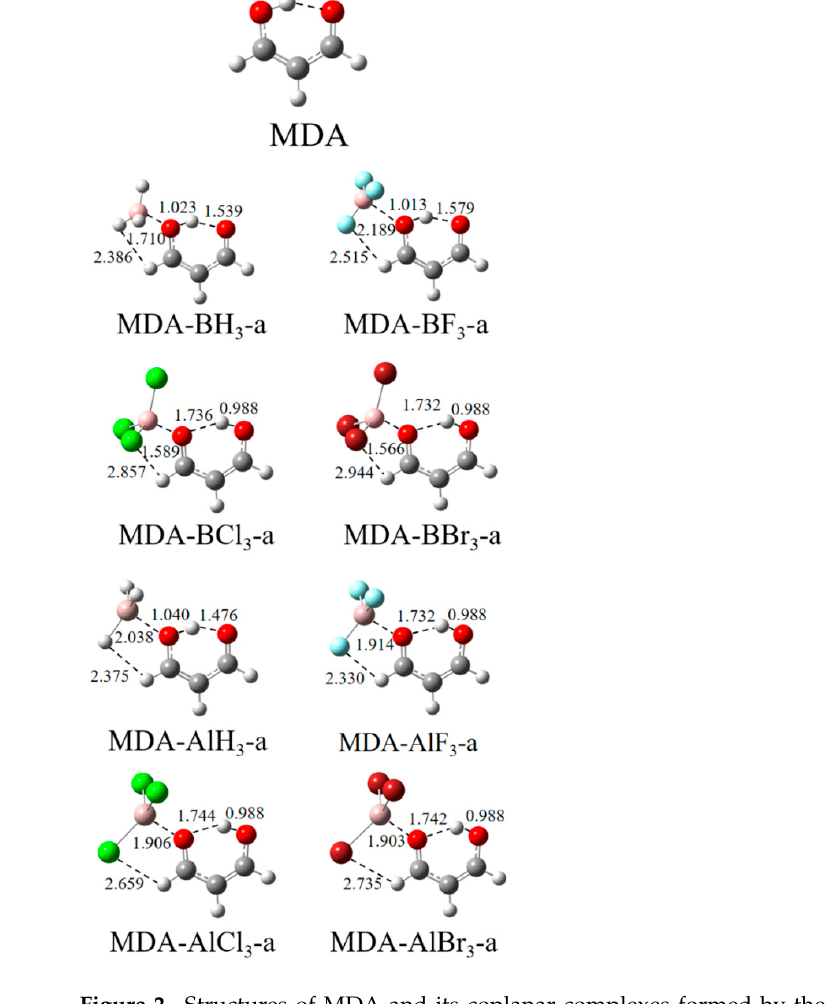
Figure 2. Structures of MDA and its coplanar complexes formed by the hydroxyl O with TrX 3 . Distances are in Å.